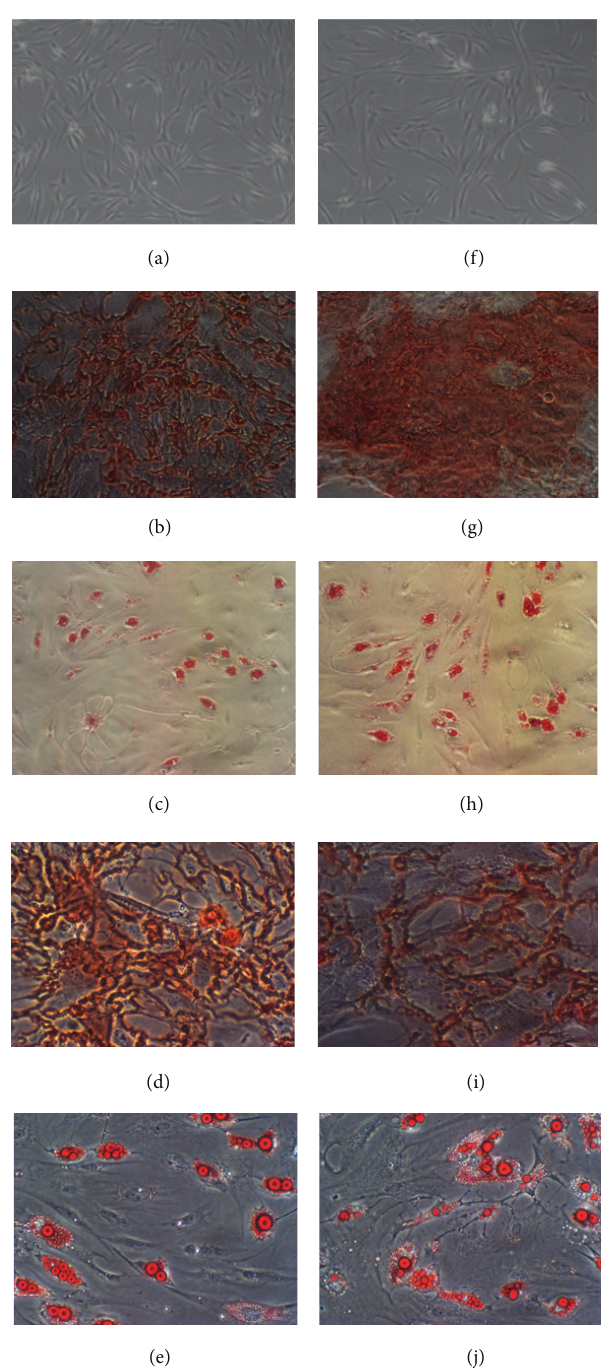
Figure 2: Morphology and differentiation potential of control and treated MSCs. MSCs cultured in either standard culture media or HA media. No detectable differences were seen in the morphology of control (a) MSCs and HA treated (f) monolayers. Osteogenic differentiation of control MSCs (b) and of the HA treated (g) at 10x magnification. Adipogenic differentiation of control (c) and of the HA treated (h) at 10x magnification. At 20x magnification no detectable differences in Alizarin Red S staining were observed in the osteogenic differentiation of control MSCs (d) and HA treated (i). At 20x magnification no detectable differences in Oil Red O staining were observed in the adipogenic differentiation of control MSCs (e) and HA treated